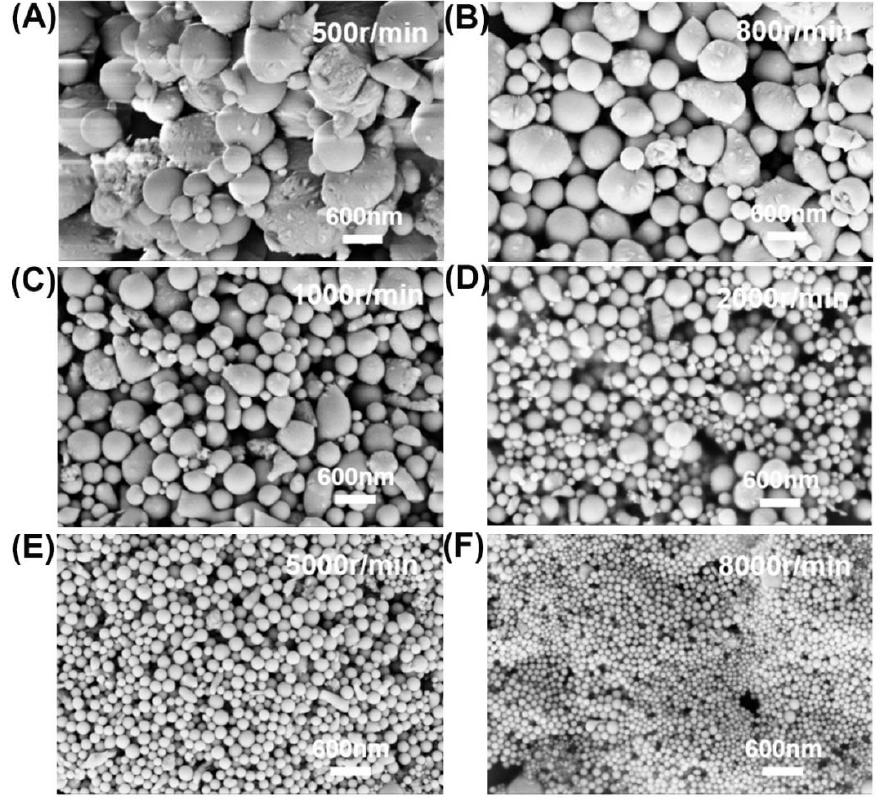
Figure 7. Morphology images of eGaIn nanodroplets under different centrifugal speeds: ( A ) 500 r/min, ( B ) 800 r/min, ( C ) 1000 r/min, ( D ) 2000 r/min, ( E ) 5000 r/min, and ( F ) 8000 r/min.